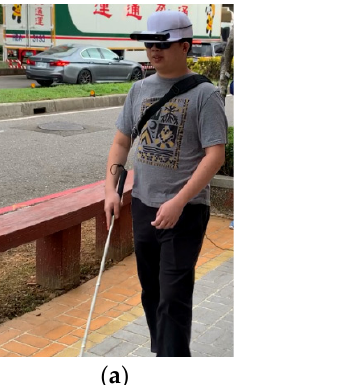
Figure 11. The car appears in the third and fourth divisions from the right.